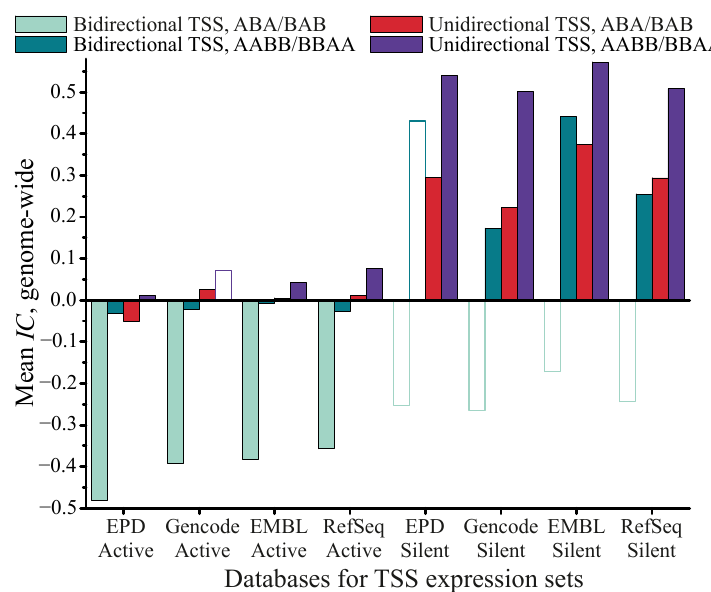
Figure 7. Genome-wide comparison of indices of coverage for colocalization between histone isoform H2AFZ and bi- and unidirectional TSS related to active and silent genes for cell line K562. Non-filled bars indicate the indices that are not statistically significant (| z | < 1.96, p >